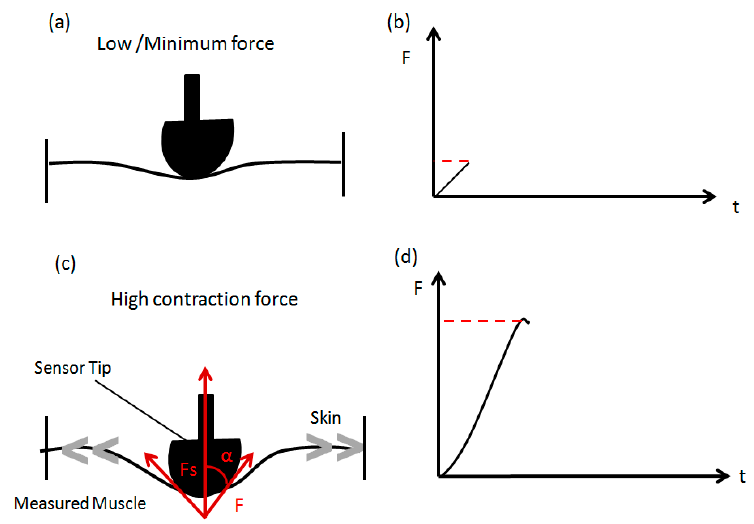
Figure 2 . SCI individual seated on the dynamometer during FES-evoked contractions. The placement of neuromuscular stimulating electrodes and MC sensor over the subject’s rectus femoris muscle is shown.